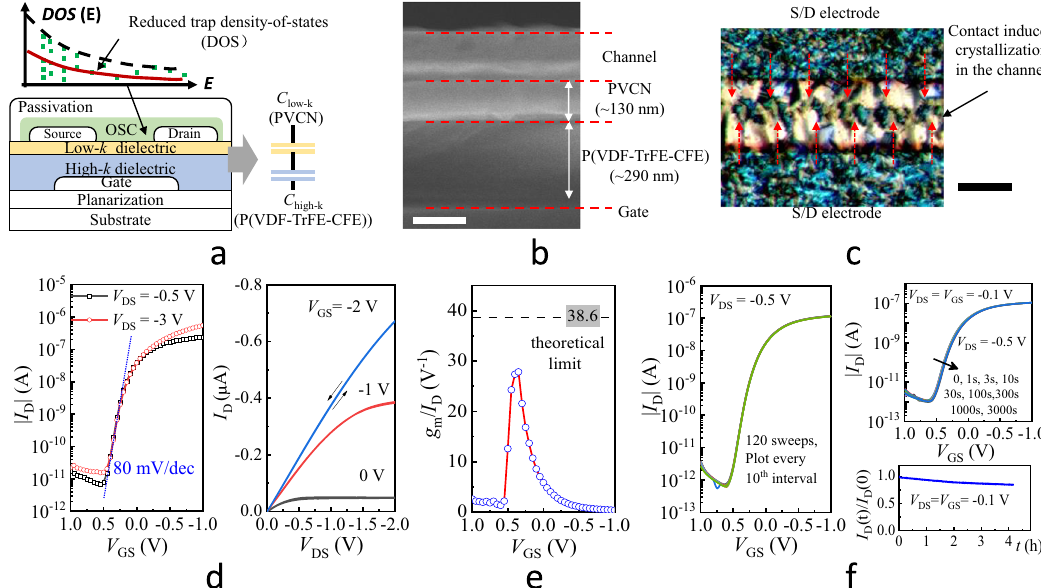
Fig. 2 Microscopic and electrical characterization of OFET. a Schematic of the OFET in a bottom-gate bottom-contact structure fabricated on a polyethylene naphthalate (PEN) substrate combining low trap density-of-state (DOS) channel and high- k /low- k gate dielectric layer. b Cross-sectional scanning electron microscopy (SEM) image showing the material stack of the OFET. The scale bar is 200 nm. c Polarized optical micrograph showing contact-induced crystallization along the channel with the per fl uorobenzenethiol-modi fi ed silver source/drain electrodes. The scale bar is 50 μ m. d Measured typical transfer ( I D – V GS ) and output ( I D – V DS ) characteristics with well-behaved fi eld-effect transistor behaviors and a steep subthreshold swing of about 80 mV·dec − 1 (W/L = 2000 µm/70 µm). e The extracted transconductance ef fi ciency ( g m / I D ) as a function of the gate-to-source voltage ( V GS ) with the maximum value of 28.8 V − 1 exceeding those of previously reported extended-gate OFET biosensors. f Left: the measured I D – V GS curves at each 10 th interval under continuously sweeping V GS from OFF to ON for 120 times. Right: the measured I D – V GS curves under continuous bias stress ( V GS = V DS = − 0.1 V) with the measured normalized drain current over the original value ( I D (t)/ I D (0)) for 4